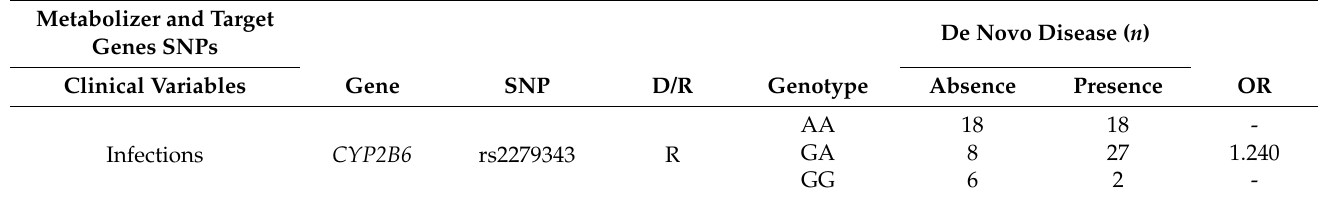
Table 7. Pharmacogene variants associated with other clinical variables selected by multivariate logistic regression and regularized by elastic net statistical analysis. Metabolizer and target pharma-